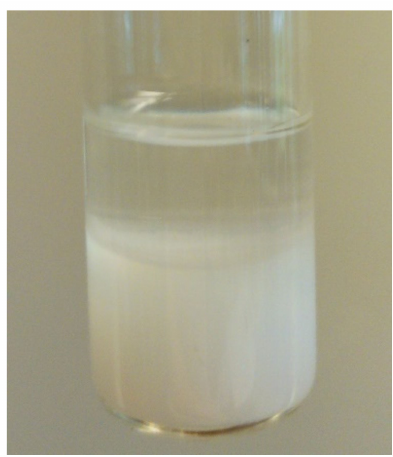
Figure A1. The material after stirring.